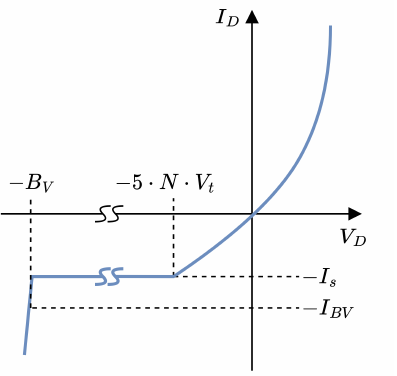
Figure 12. A parametric illustration of the current–voltage relationship of the default SPICE LSDM. Developed from